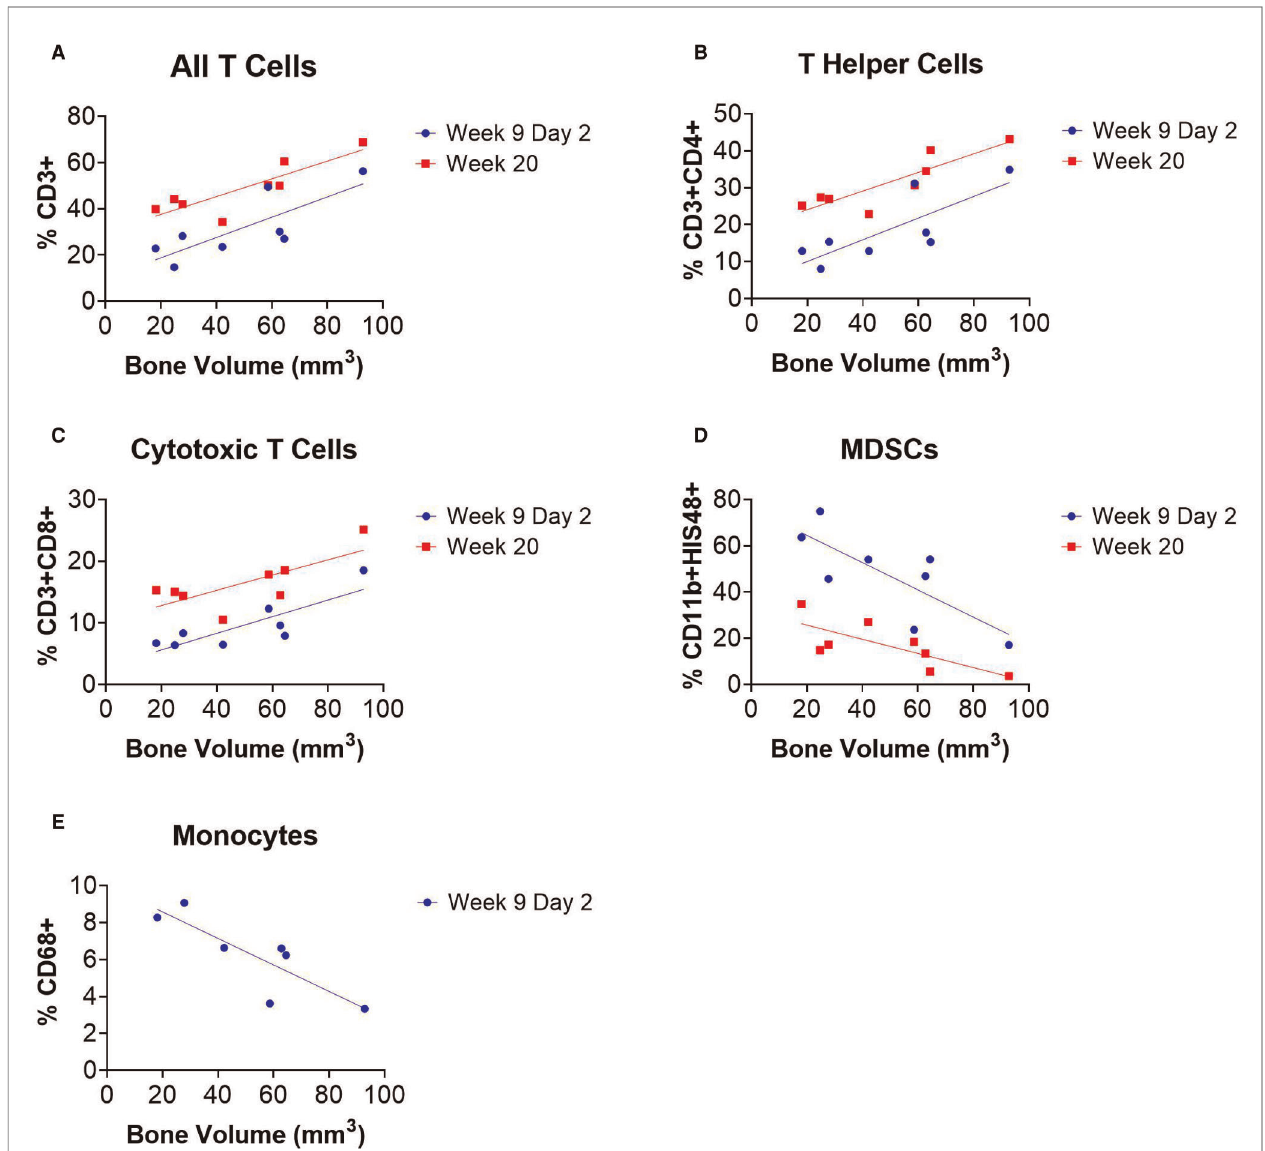
FIGURE 6 | Circulating immune cells correlate with bone regeneration in rats treated with synthetic nanoparticle antibodies (SNAbs). ( A – E ) Immune cell populations from peripheral blood at multiple timepoints signi fi cantly correlate with week 20 bone volumes as measured by ex vivo µCT. T cells, T helper cells, and cytotoxic T cells were positively correlated with bone regeneration ( A – C ), while MDSCs and monocytes were negatively correlated ( D,E ). Pearson correlation analyses performed, n = 7 – 8 per time point, slope of linear regression signi fi cantly nonzero for all data shown ( P